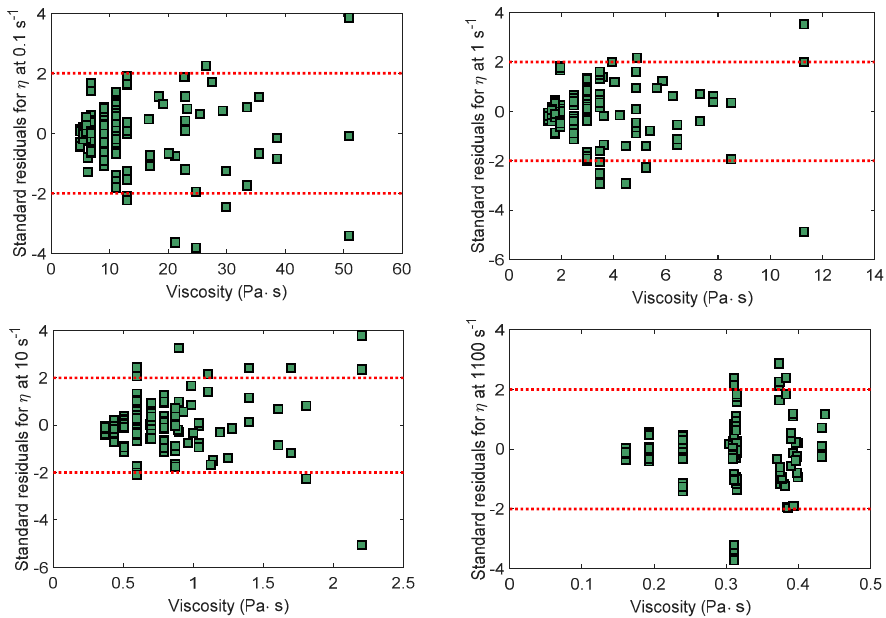
Figure 5. Predicted viscosities against measured viscosities at 0.1 s − 1 . Training and validation: grey circle; test: green diamond.